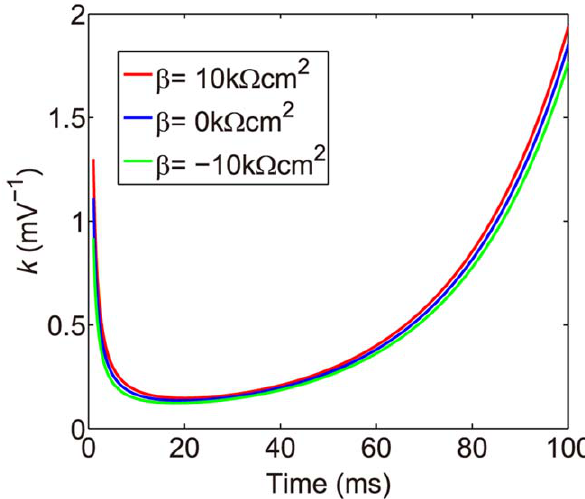
Figure 5. The shunting coefficient k M as a function of time. With three different values of b : b ~ 10k V : cm 2 (thick dark line: red online), b ~ 0k V : cm 2 (thick gray line: blue online), b ~{ 10k V : cm 2 (light gray line: green online). Here a is fixed as a ~{ 8k V : cm 2 . It can be seen that k M is nearly independent of the parameter b .